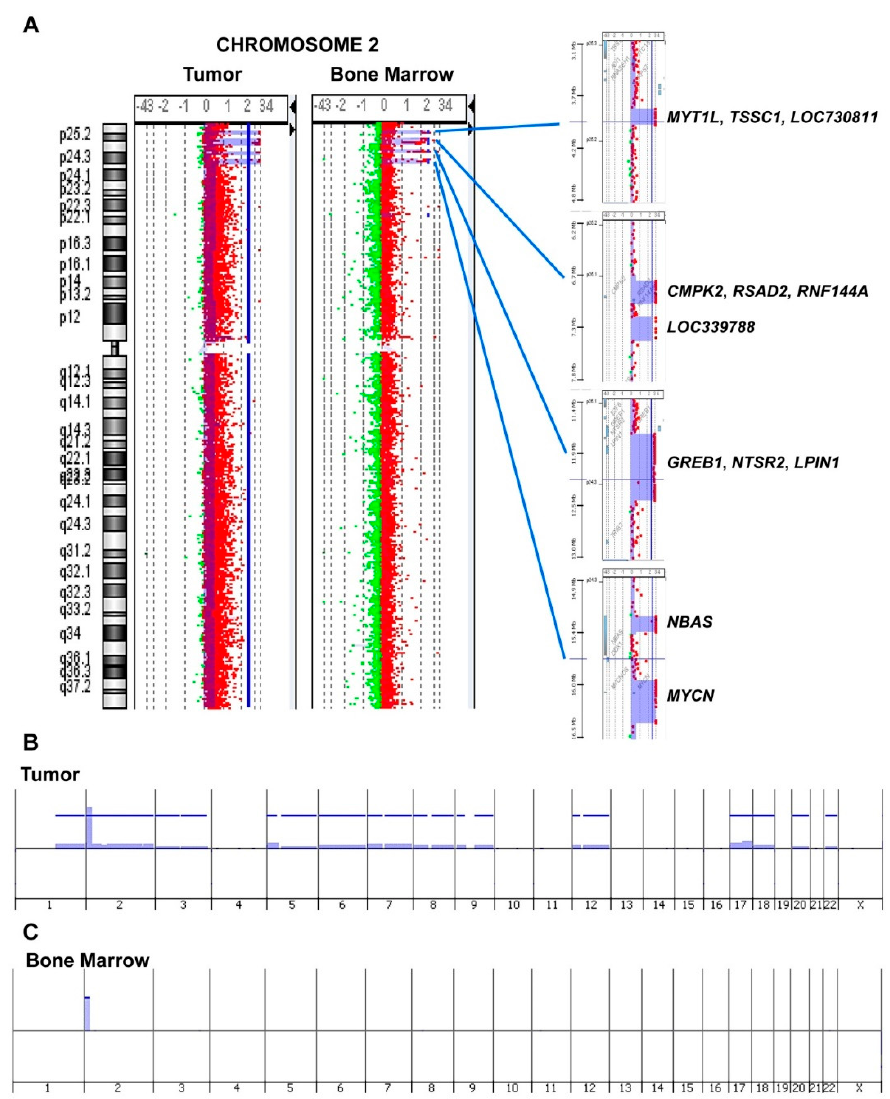
Figure 1. Genomic findings. ( A ) The six co-amplified regions on bands 2p25.3–p24.3 detected in NB primary tumor and in metastatic bone marrow aspirate cells from the patient. Genomic profiles obtained by array ‐ CGH highlighted high level amplifications of six loci: 2p25.3, containing MYT1L , TSSC1 and LOC730811 ; 2p25.2, containing CMPK2 , RSAD2 , and RNF144A ; 2p25.1, containing LOC339788 ; 2p25.1–p24.3, containing GREB1 , NTSR2 , and LPIN1 ; 2p24.3, containing NBAS ; 2p24.3, containing MYCN . ( B ) Primary tumor showed a genomic profile with recurrent segmental chromosome alterations (SCA profile) typical of NB such as 1q gain and 17q gain, the atypical 2p25.3–p24.3, and 12 numerical chromosome alterations. ( C ) Metastatic bone marrow aspirate cells